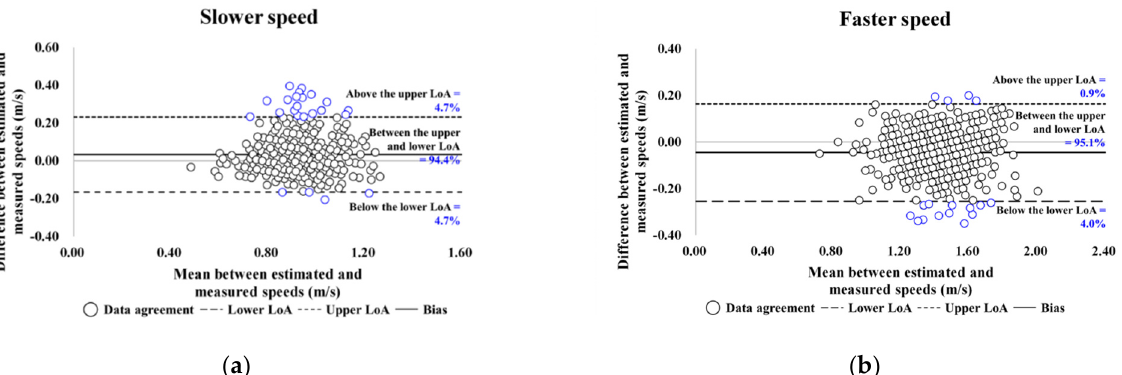
Figure 3. Bland–Altman plots for data agreement between the estimated and measured overground walking speeds: ( a , b ) are the slower and faster speed results for older women. LoA, limits of agree- ment.